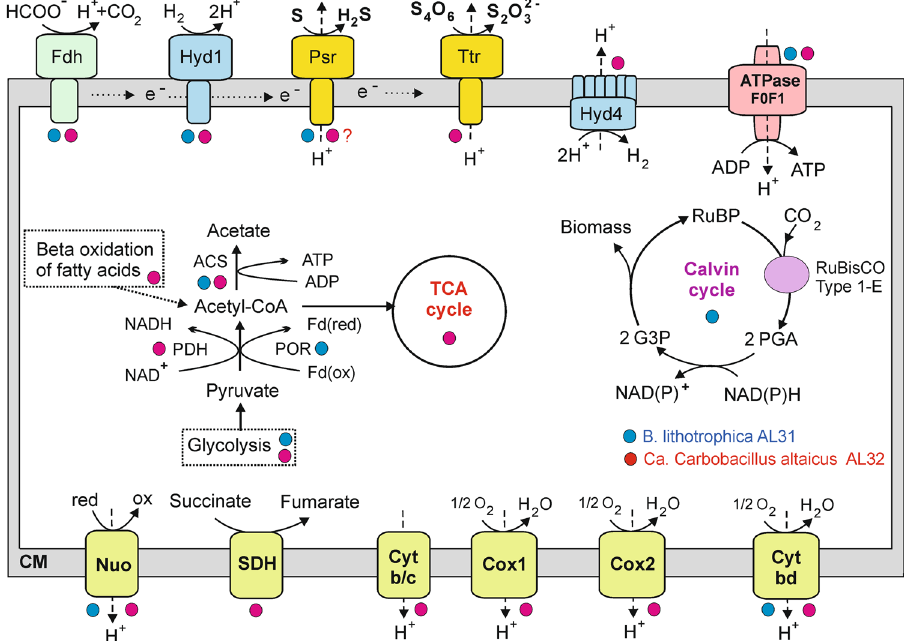
Figure 5. An overview of the metabolism of B. lithotrophica AL31 and Ca . Carbobacillus altaicus AL32 reconstructed from their genomes. Enzyme abbreviations: POR, pyruvate ferredoxin oxidoreductase; PDH, pyruvate dehydrogenase; ACS, acetyl-CoA synthetase; Fdh, formate dehydrogenase; Hyd1, membrane- bound group 1 [NiFe] uptake hydrogenase; Hyd4, membrane-bound group 4 f [NiFe] hydrogenase; Psh, polysulfide/thiosulfate reductase Ttr, tetrathionate reductase; ATPase F0F1, F 1 F 0 – type ATP synthase; Nuo, membrane-linked complex comprising subunits NuoA, B, C, D, H, I, J, K, L, M and N of NADH-ubiquinone oxidoreductase; SDH, succinate dehydrogenase; Cyt b/c, cytochrome b/c complex, Cox, cytochrom c oxidase; Cyt bd, quinol oxidase bd complex. Other abbreviations: ox/red, oxidized and reduced forms; RuBP, ribulose-